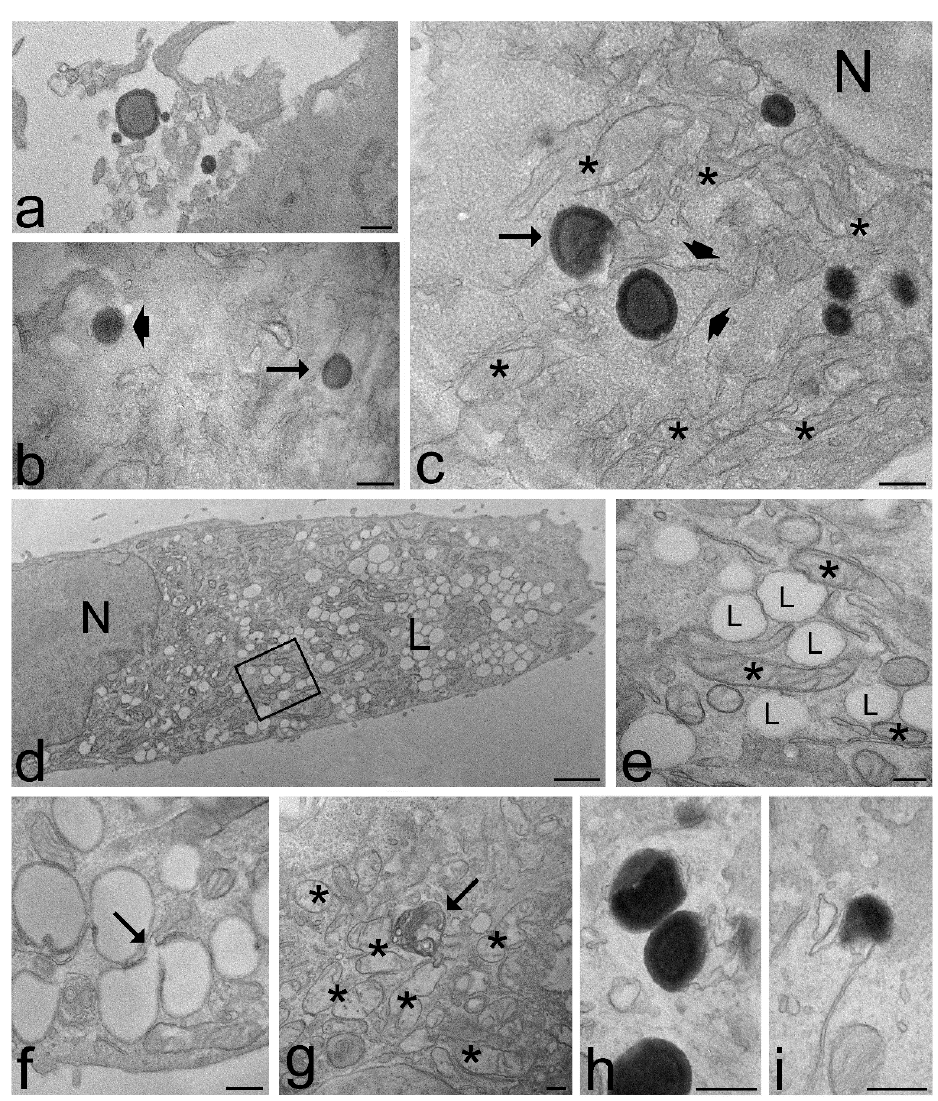
Figure 8. Transmission electron micrographs of keratinocytes ( a , f , g , h ), fibroblasts ( d , e ) and myoblasts ( b , c , i ) and after 2 h ( a – c ) and 24 h incubation ( d – i ) with TET. ( a ) Some TET occur among microvilli on the cell surface. ( b ) A TET (arrowhead) is entering the cell, while another TET (arrow) occurs free in the cytosol. ( c ) Some TET are distributed in the cytoplasm, sometimes very close to the nucleus (N); note the crescent-like TET (arrow) and the good morphology of mitochondria (asterisks) and endoplasmic reticulum (arrowheads). ( d , e ) After 24 h incubation, the cells contain large amounts of lipid droplets (L) of small size; they occur very close each other and are often surrounded by mitochondria (asterisks); ( e ) high magnification detail corresponding to the framed area in ( d ). ( f ) Two coalescing lipid droplets (arrow). ( g ) After 24 h incubation with TET, some mitochondria swell and lose their cristae (asterisks), and residual bodies (arrows) occur. ( h , i ) The scarce morphologically recognizable TET show different degradation steps. Bars 200 nm ( a – c , e – i ), 1 µ m ( d After 2 h incubation, the intracellular distribution of nanocarriers, their morphology or the cell structural features were similar in cells treated with ET or TET. On the contrary, after 24 h incubation, the intracellular fate of ET and TET appeared strikingly different.